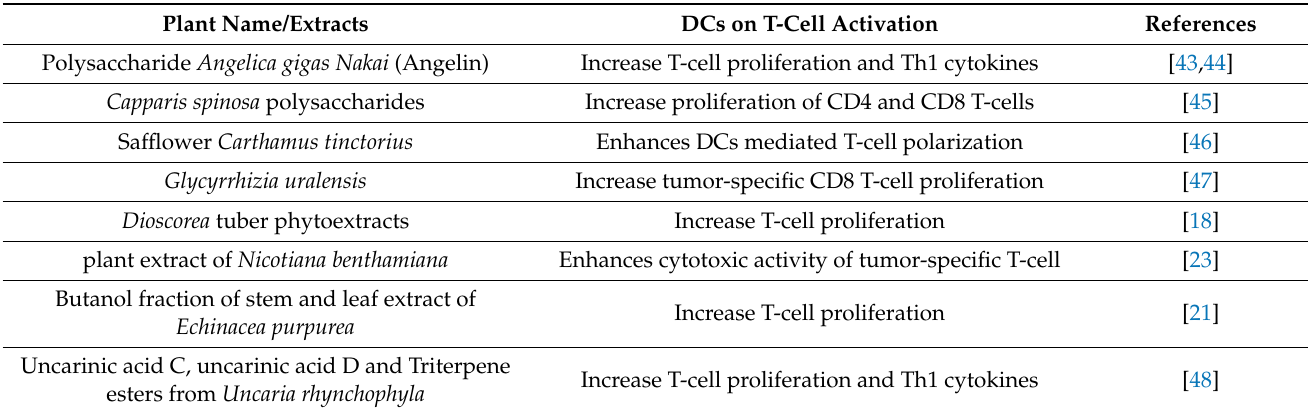
Table 2. Plant extract pulsed DCs on T-cell